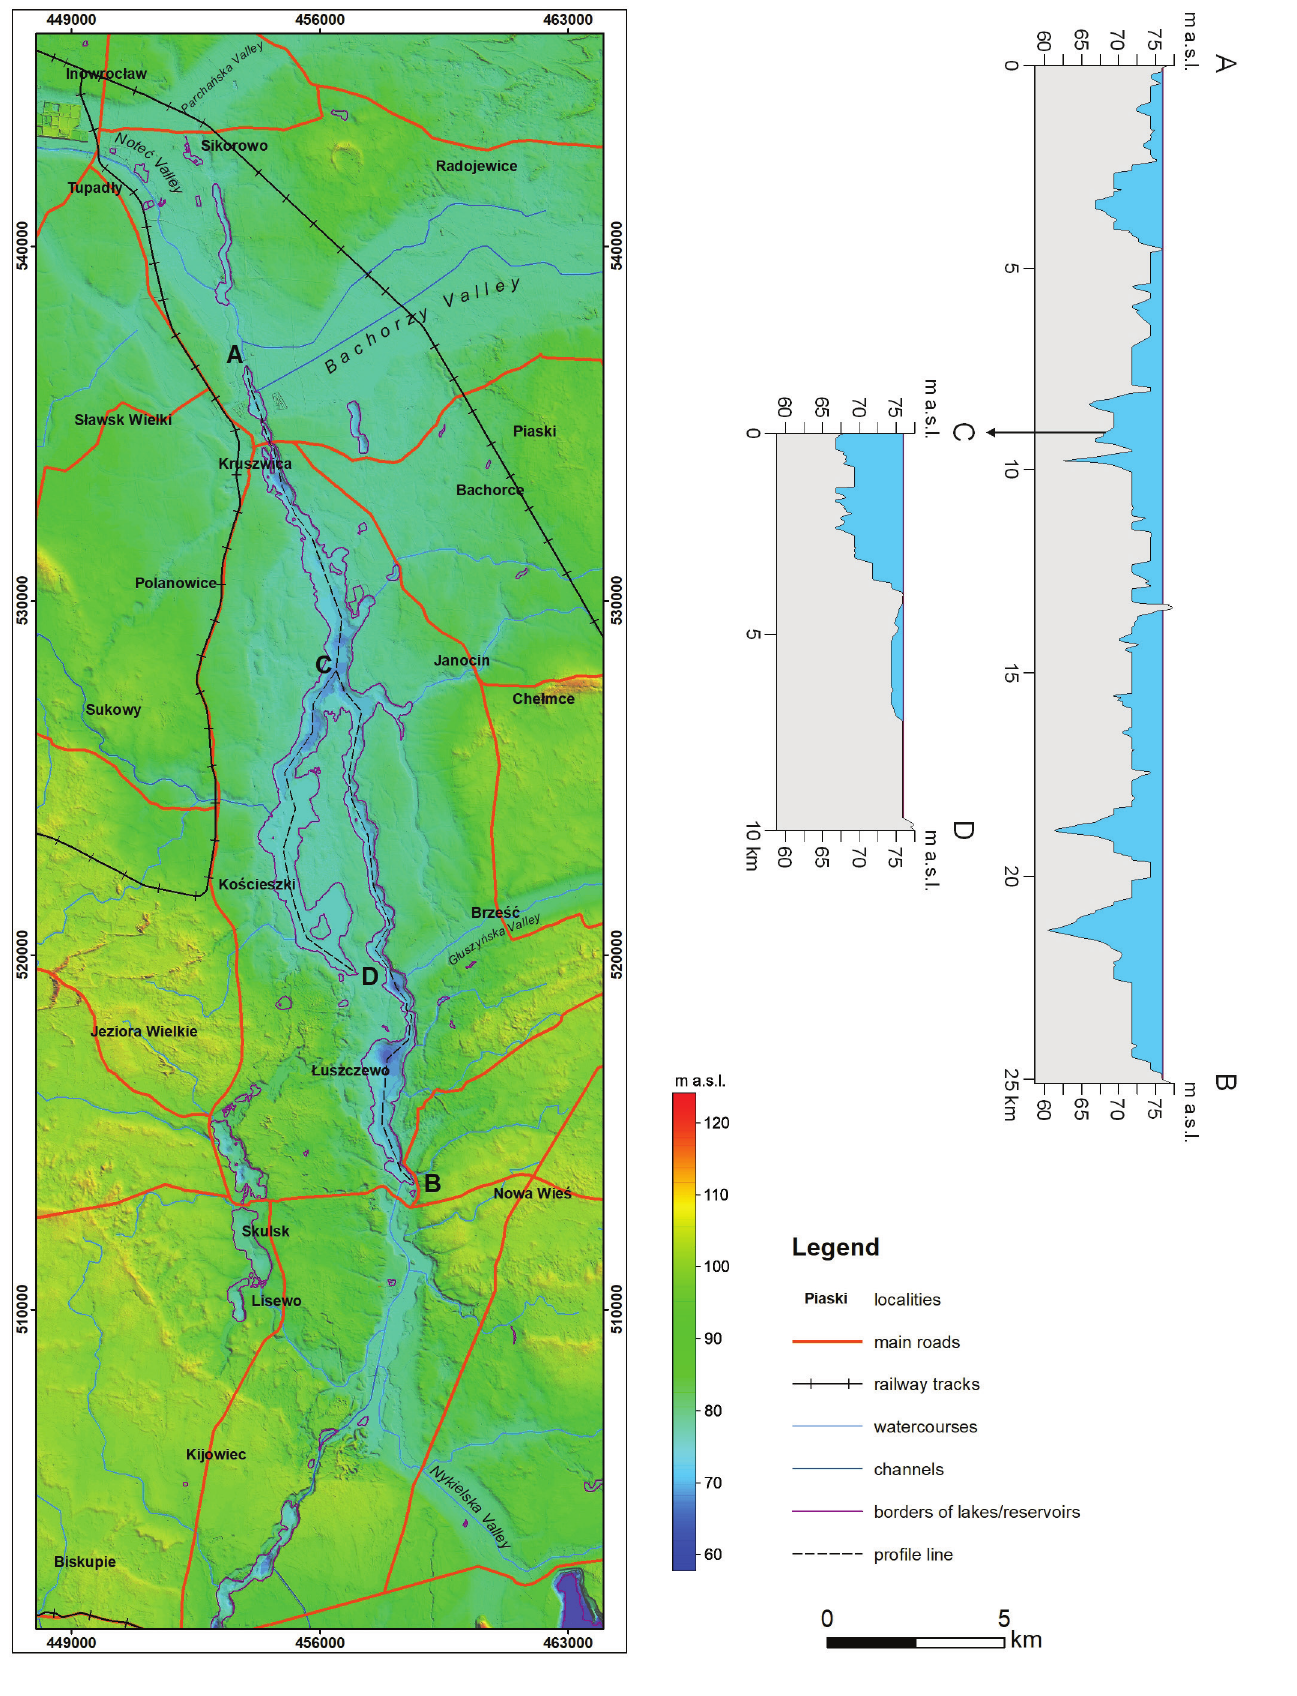
Figure 5. DTM of the research area and longitudinal profile of Lake